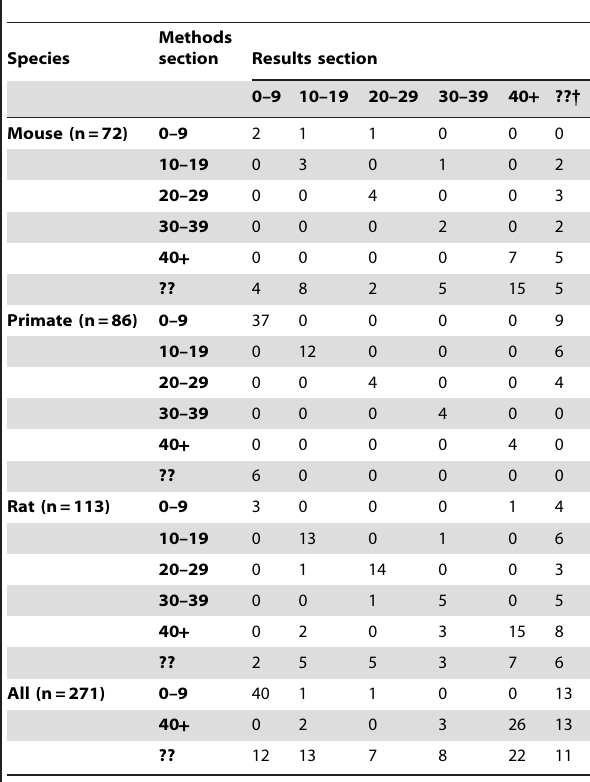
Table 11. Number of animals reported in methods and results sections for each study.